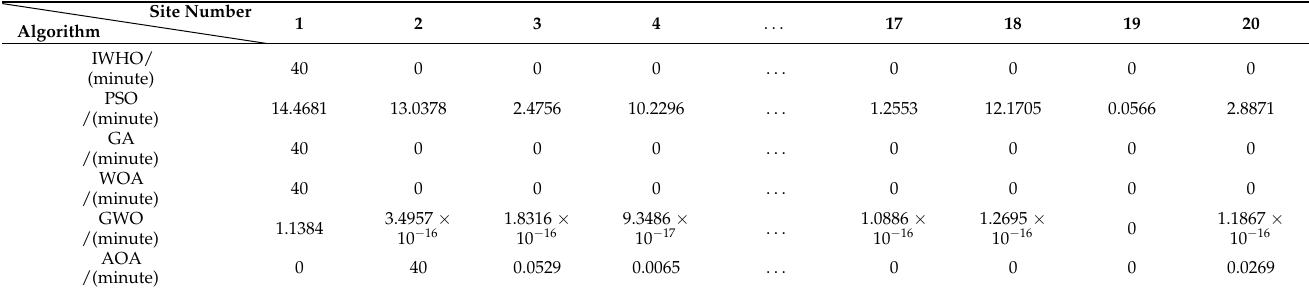
Table 3. Optimal waiting strategy for each algorithm in one randomized